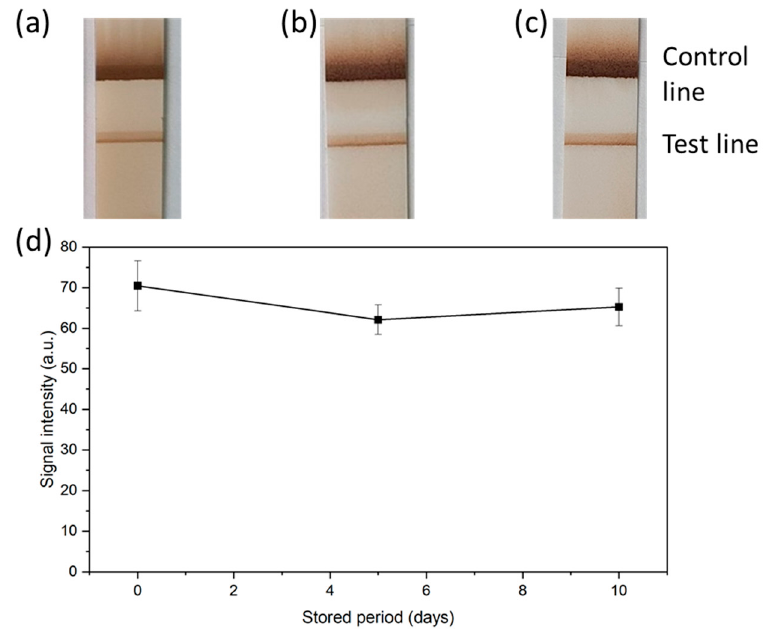
Figure 6. Photos of 5 × 10 7 CFU/mL E. coli O157:H7 ( a ) immediately after immobilizing antibodies on the NC strip, ( b ) 5 days after, and ( c ) 10 days after immobilization. ( d ) Graph showing the quantified signal intensity of the test line obtained from the stability test.